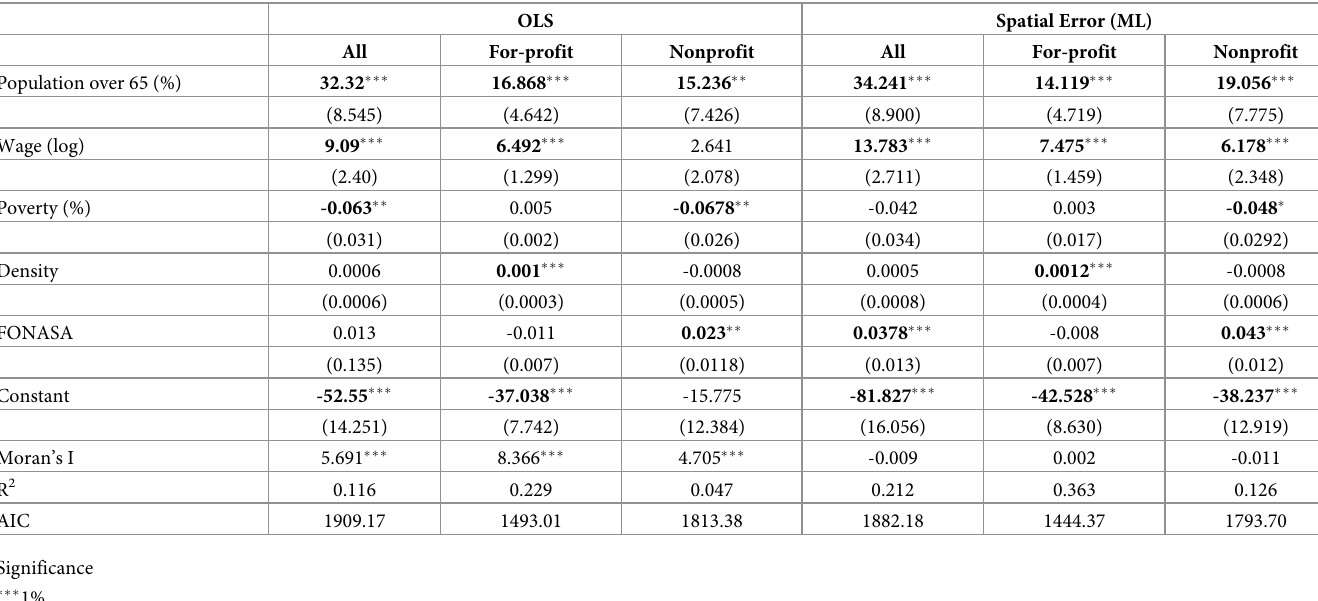
Table 4. Determinants of availability: OLS and spatial error estimations (N =